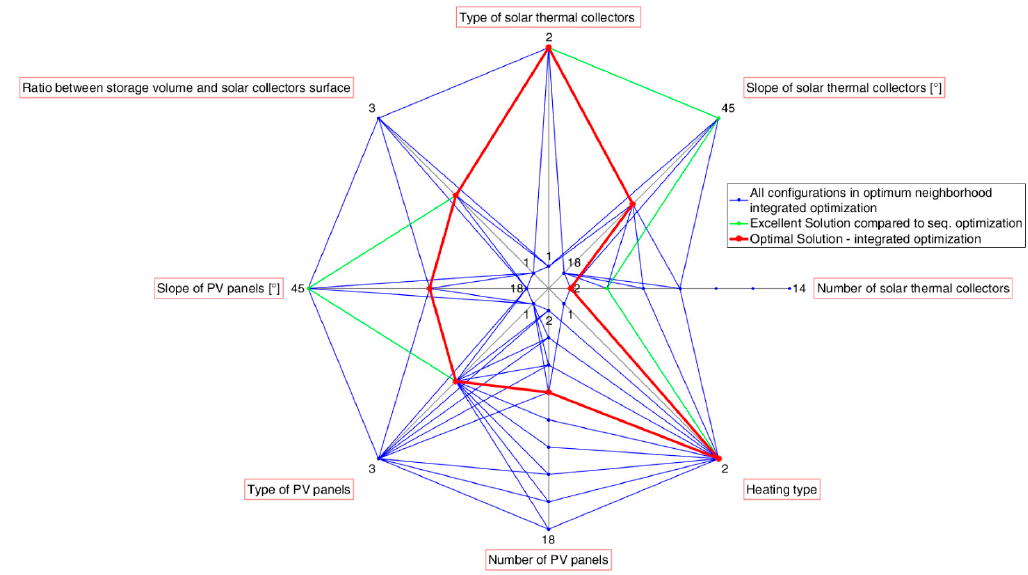
Figure 14. Passive parameters in the optimum neighborhood: integrated optimization and financial objective.